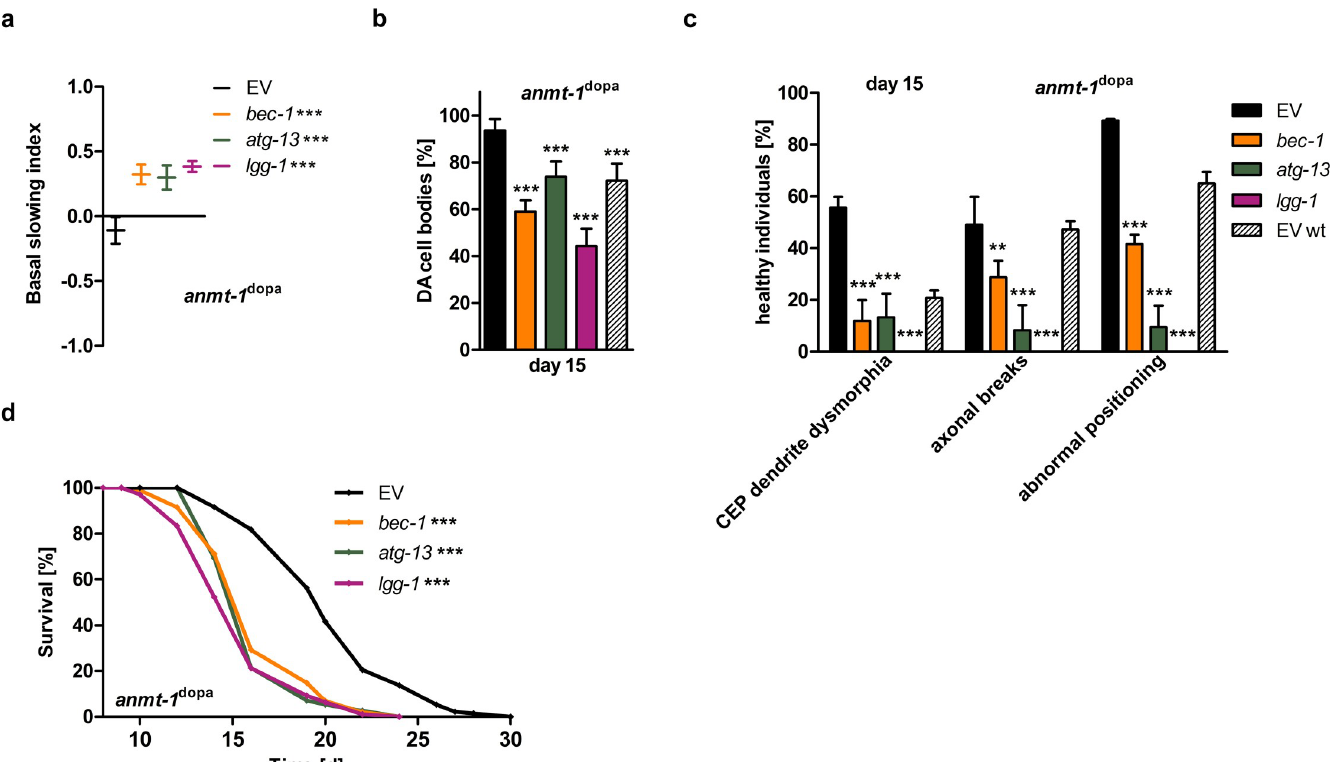
Fig 3. Neuronal autophagy mediates anmt-1 dopa -induced phenotypes. a Basal slowing index of anmt-1 dopa with a neuronal RNAi-sensitive background treated with RNAi against bec-1 (orange), atg-13 (green), or lgg-1 (purple) compared to control RNAi (EV; black) at day 5 of adulthood. b Presence of (DA) cell bodies in anmt-1 dopa with a neuronal RNAi-sensitive background treated with RNAi against bec-1 , atg-13 , or lgg-1 compared to EV and wt EV (patterned) at day 15 of adulthood. c DA neuronal morphology in anmt-1 dopa with a neuronal RNAi-sensitive background treated with RNAi against bec-1 , atg-13 , or lgg-1 compared to EV and wt EV at day 15 of adulthood. d Lifespan of anmt-1 dopa with a neuronal RNAi-sensitive background treated with RNAi against bec-1 , atg-13 and lgg-1 compared to EV. �� : p < 0.01, ��� : p < 0.001.